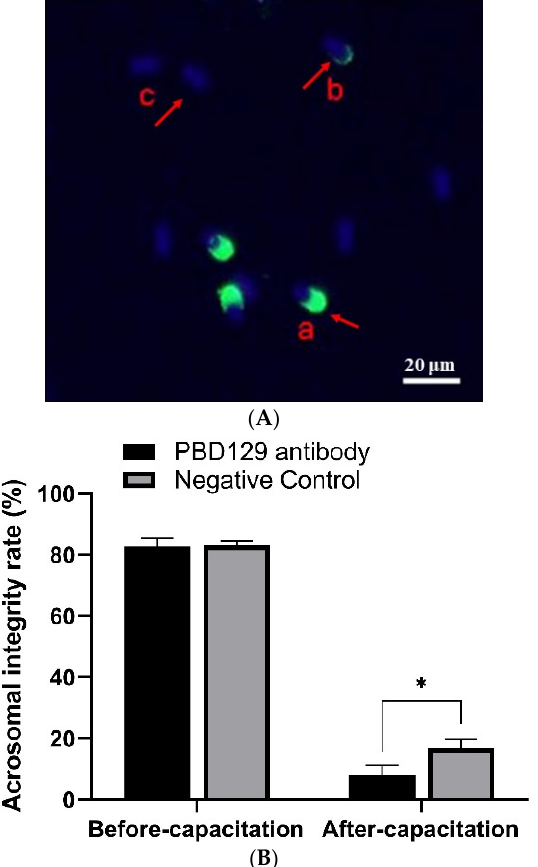
Figure 7. Effects of anti-pBD129 antibody on the rate of acrosome reaction after sperm capacitation in vitro . ( A ) Sperm in different statuses. Sperm samples were fixed with FITC-PNA and Hoechst33342, and scored according to the state of acrosome. a: sperm has not experienced acrosome reaction, and b and c indicate that acrosome reaction has occurred. ( B ) Analysis of sperm acrosome reaction rate before and after capacitation with anti-pBD129 antibody. The mouse IgG as negative control. Data are presented as the mean ± SEM, n = 3. * p < 0.05.